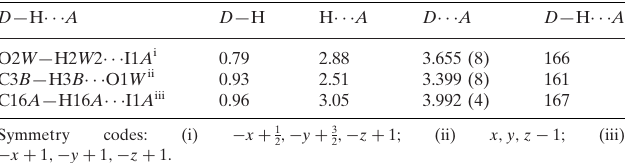
Hydrogen-bond geometry (A˚ , (cid:4)